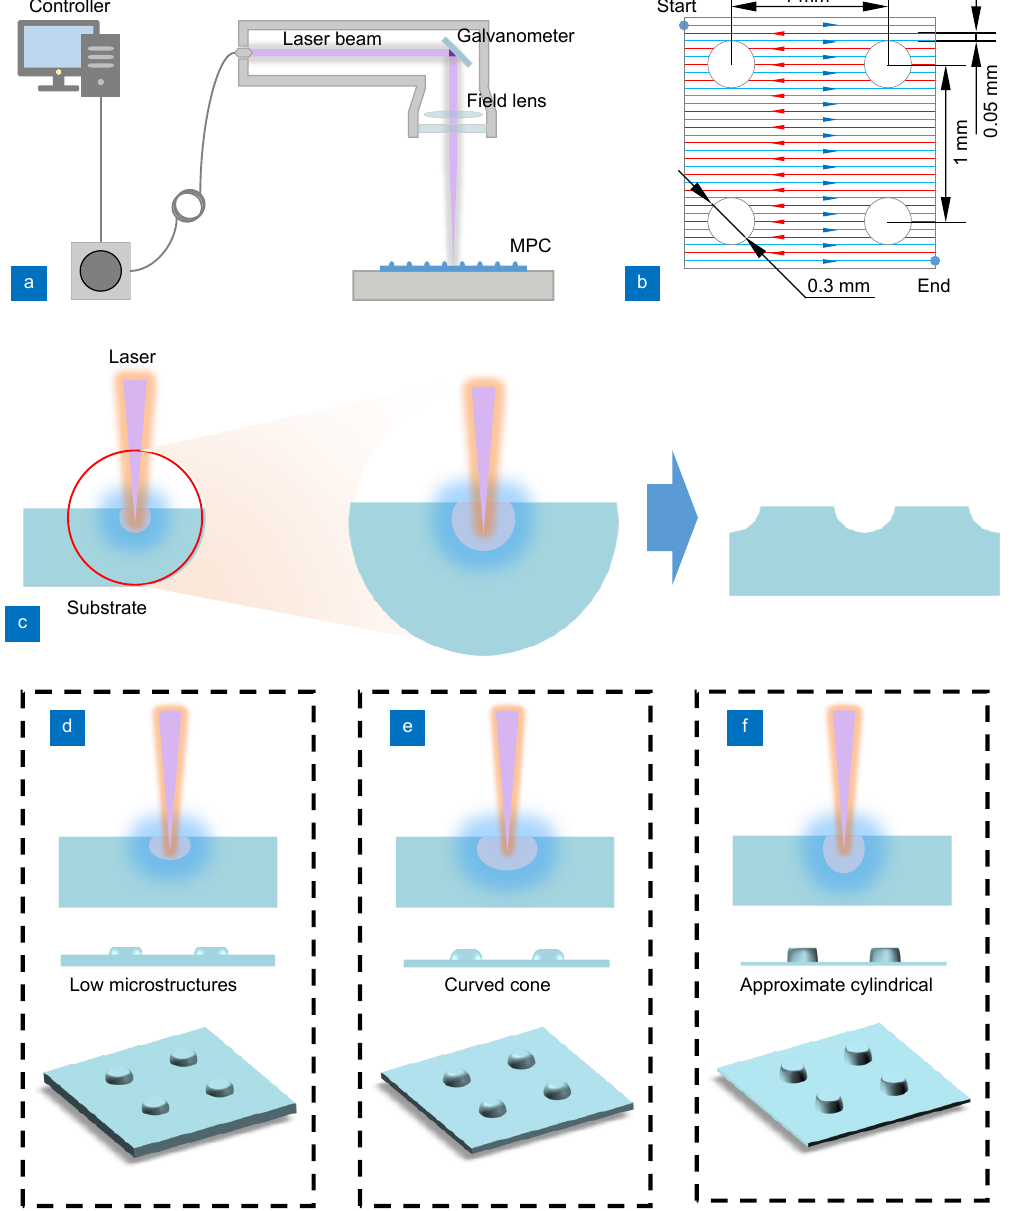
Fig. 3 | Fabrication of microstructures. ( a ) Processing system of LDW. ( b ) Laser scanning strategy. ( c ) Schematic of laser processing. ( d ) Pro- cessing schematic of low microstructures. ( e ) Processing schematic of curved cone-like microstructures. ( f ) Processing schematic of approxim- ate cylindrical